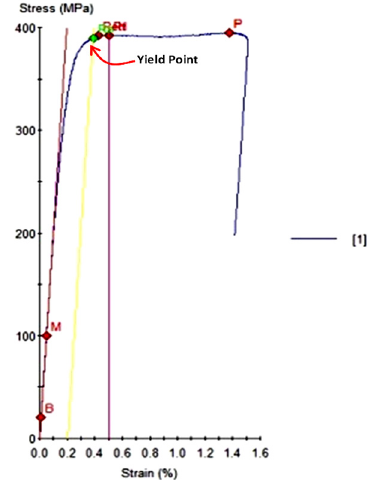
Figure 6. The stress–strain relationship of steel reinforcement.